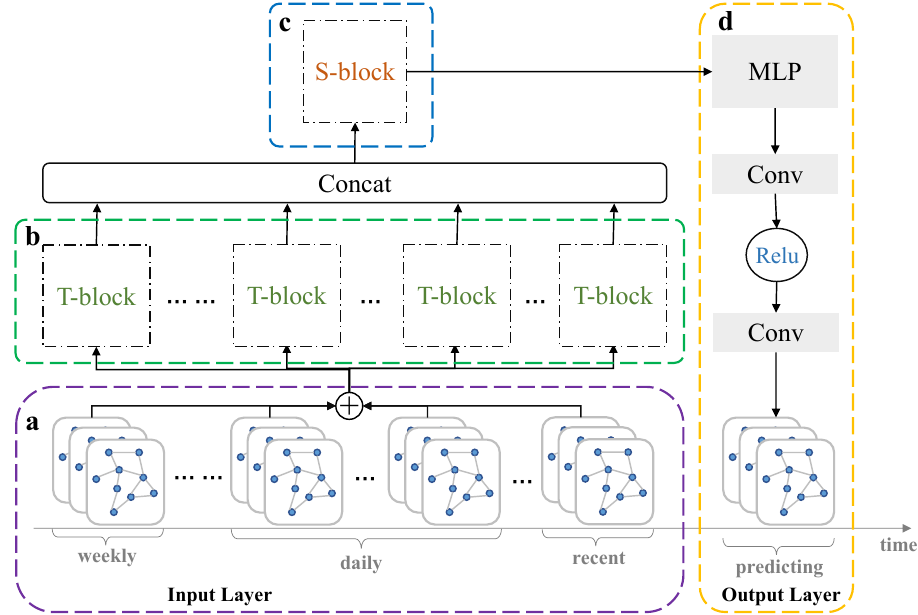
Figure 3. Illustrative architecture of the proposed spatial-temporal diffusion convolutional network (ST-DCN). ST-DCN consists of ( a ) an input layer, ( b ) a temporal convolution module, ( c ) a spatial convolution module, and ( d ) an output